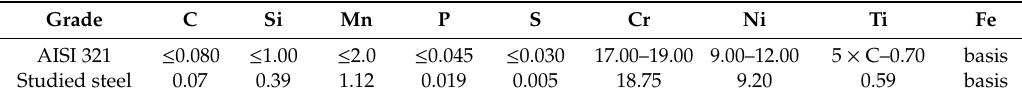
Table 1. Content of chemical elements wt